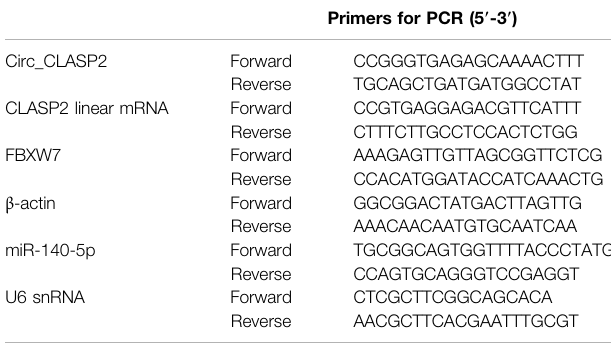
TABLE 1 | Primers sequences for